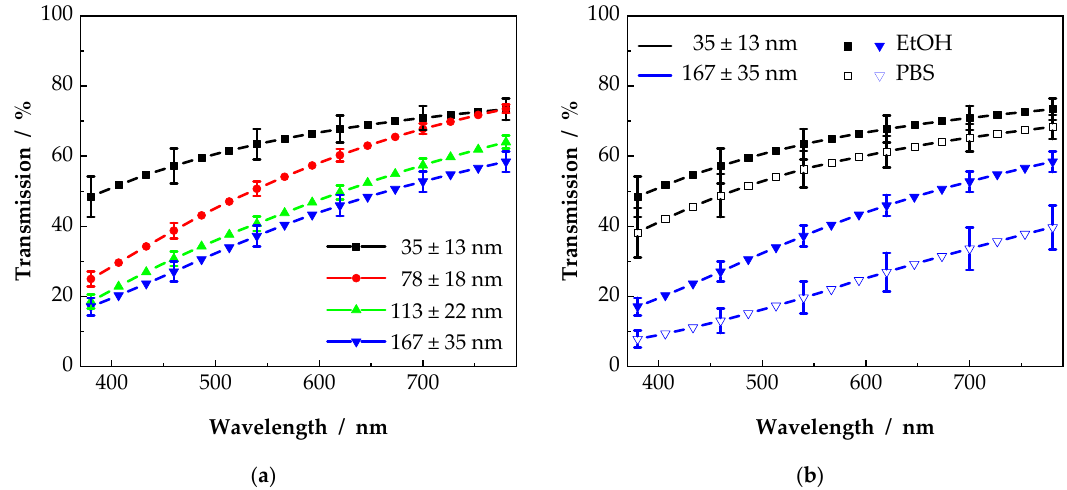
Figure 6. Examples of extracted contour lines from Figure 5. Transmission values were taken for scaffolds with a thickness of 10 µm. Light transmission increases with a decreasing fiber diameter ( a ) as well as with a decreasing ratio of the refractive indices ( b ).